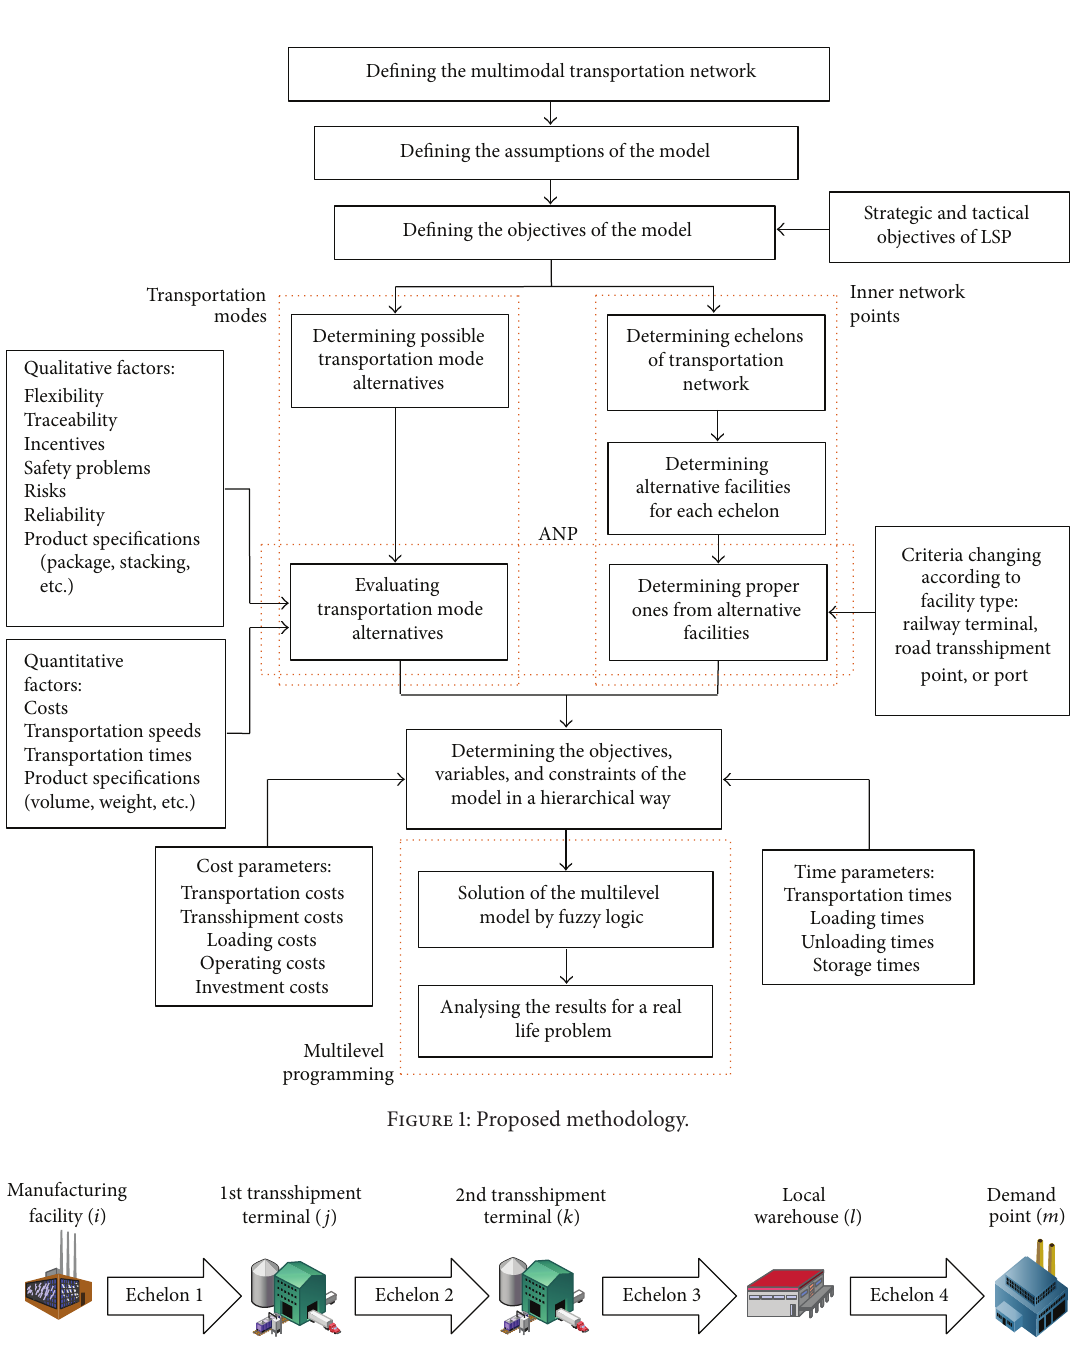
Figure 2: Transportation network